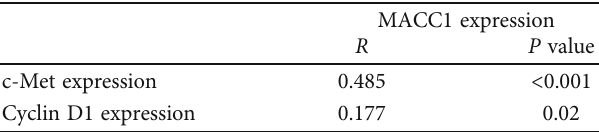
Table 4: Correlation between MACC1, c-Met, and cyclin D1.